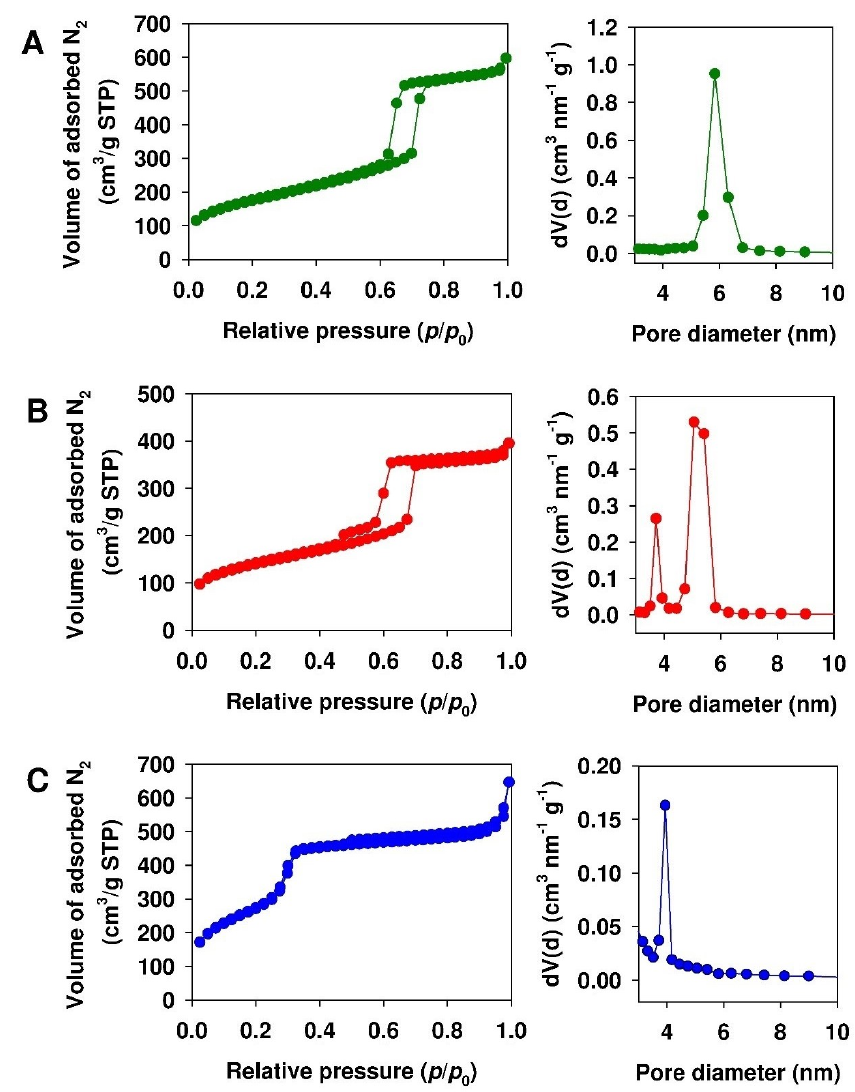
Figure 2. Nitrogen adsorption–desorption isotherms of ( A ) SBA-15-(CH 2 ) 3 -SO 3 H, ( B ) PHTS-(CH 2 ) 3 -SO 3 H, ( C ) MCM-41-(CH 2 ) 3 -SO 3 H mesoporous adsorbents. On the right, the pore size distribution of silicas is presented.